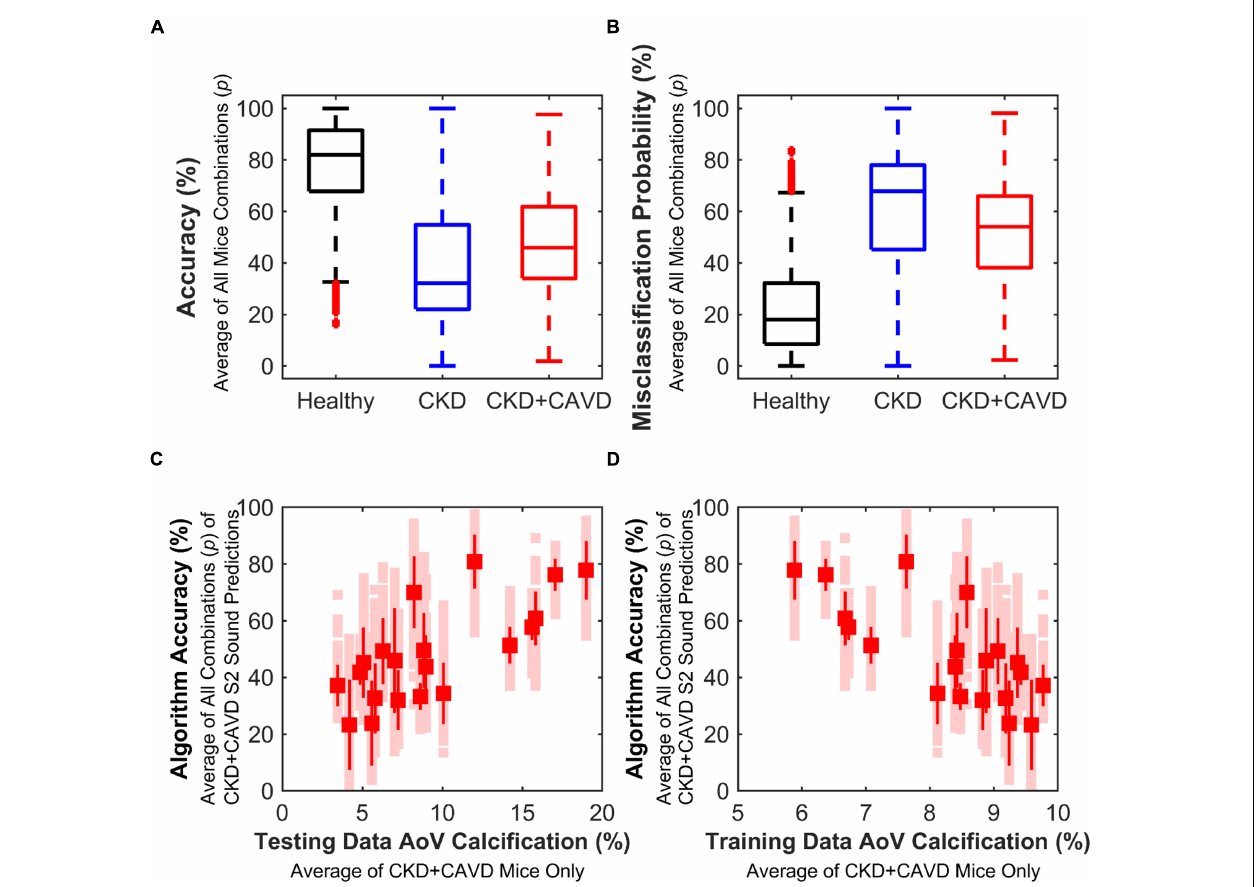
FIGURE 6 | Performance based on leave- p -out cross-validation method. Variability of algorithm performance using leave- p -out cross-validation method, which tests performance based on different combinations of mice ( p = 2,400) for training and testing sets. (A) Accuracy of all combinations. (B) Misclassification error of all combinations. (C) Correlation between algorithm accuracy and average testing set AoV calcification of CKD + CAVD mice. As testing set average AoV calcification of CKD + CAVD mice increases, accuracy of S2 sound classification increases ( r = 0.73). (D) Correlation between algorithm accuracy and average training set AoV calcification of CKD + CAVD mice. As training set average AoV calcification of CKD + CAVD mice increases, accuracy of S2 sound classification decreases ( r =